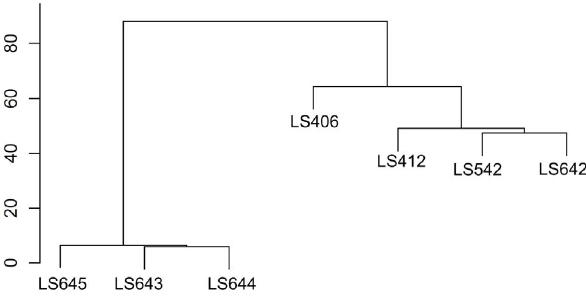
Figure 4. Hierarchical clustering based on the Robust Multi Array (RMA) analysis of the L.monocytogenes strains serotypes 4b (LS406, LS412) and IVb-v1 (LS542, LS642, LS643, LS644, LS645).